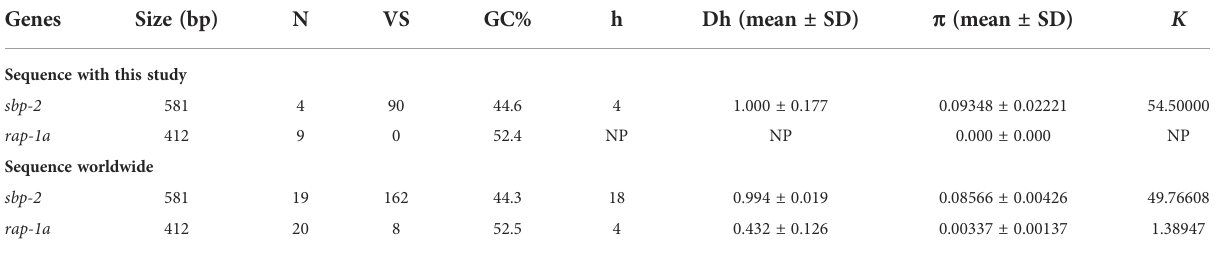
TABLE 4 Polymorphism and genetic diversity of the B. bovis sbp-2 and B. bigemina rap-1a gene sequences as examined in cattle samples in Thailand and other countries. Genes N